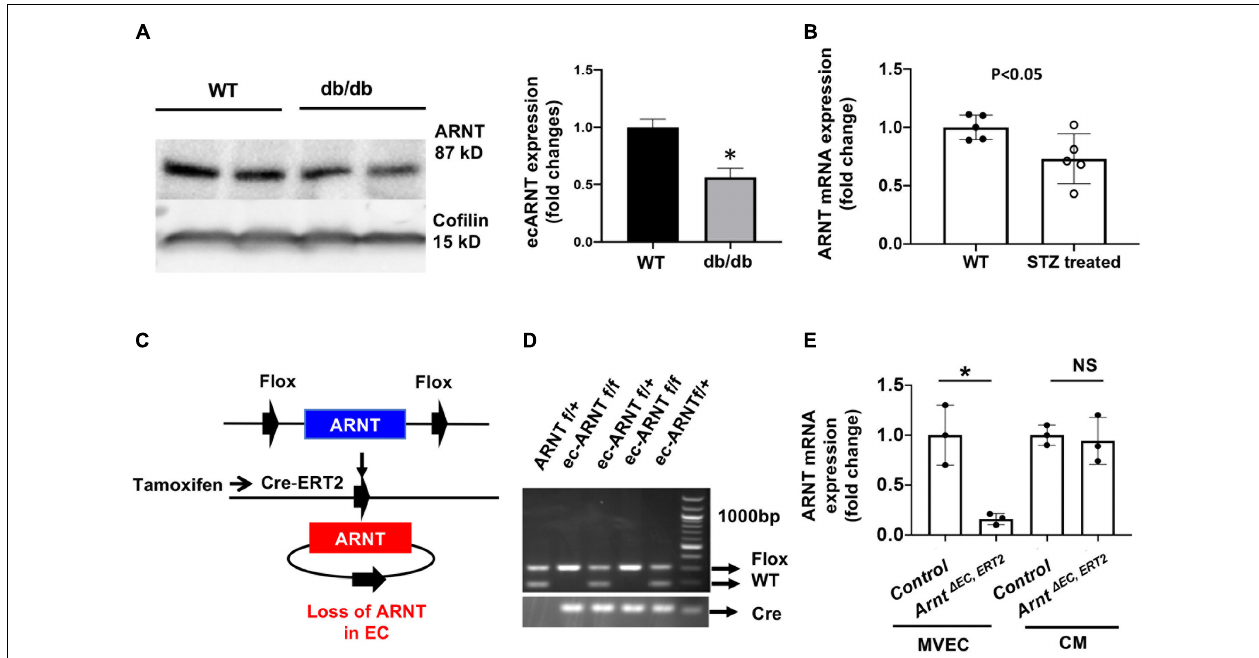
FIGURE 1 | Endothelial ARNT expression in diabetic animals and the generation of inducible endothelial-specific ARNT-deficient adult ( Arnt (cid:49) EC , ERT2 ) mice. (A) A Representative Western blot and comparison graph of ARNT protein expression levels in mouse microvascular endothelial cells (MVECs) isolated from control (db/+) and diabetic mouse (db/db) organs. (B) ARNT mRNA expression levels in MVECs isolated from control and STZ-treated diabetic mouse organs. (C) Schematic diagram of ecARNT deletion. (D) PCR analysis of genomic ARNT DNA. (E) ARNT mRNA expression levels in MVECs and isolated cardiomyocytes (CM). Data are presented as the mean ± SEM ( n = 3–6) mice per group. ∗ P < 0.01 versus WT or control